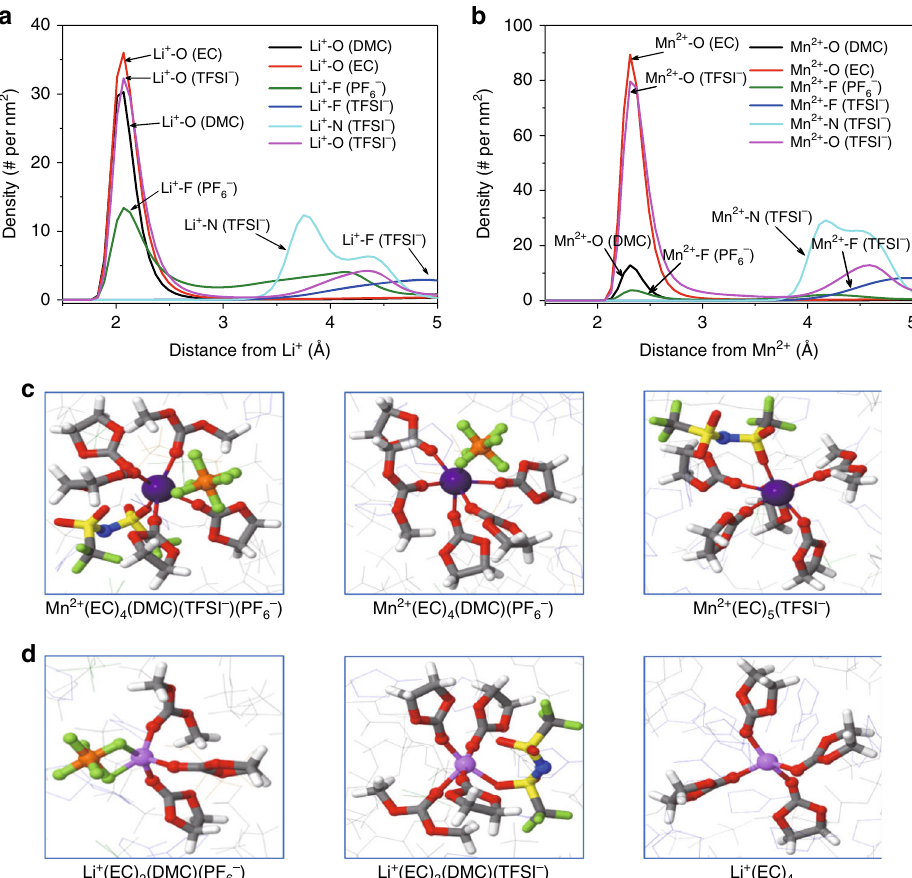
Fig. 1 Electrolyte structures obtained from molecular dynamic simulation. Radial distribution function for Li + ( a ) and Mn 2 + ( b ) in electrolytes; The typical fi rst solvation sheath structures of Mn 2 + ( c ) and Li + ( d ); Part of these structures that exist in liquid solutions can be detected by ESI-MS in gaseous state after partial desolvation of the